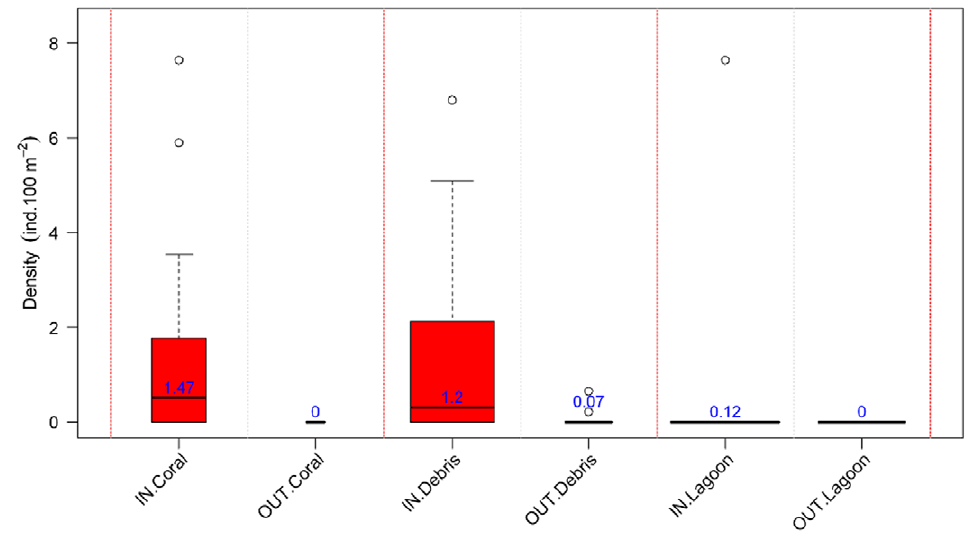
Figure 8. Distribution of Nasounicornis abundance density according to habitat (lagoon, debris and coral) and protection status (IN versus OUT of protected area). The species was not found in the other two habitats. Abundance density was the average over rotations. On each boxplot, boxes showed the interquartile (0.25, 0.75) ranges; whiskers extended to the data point at # 1.5 times the box length away from the box; values outside this range were represented by dots. Triangles indicated boxplots with less than 5 data.